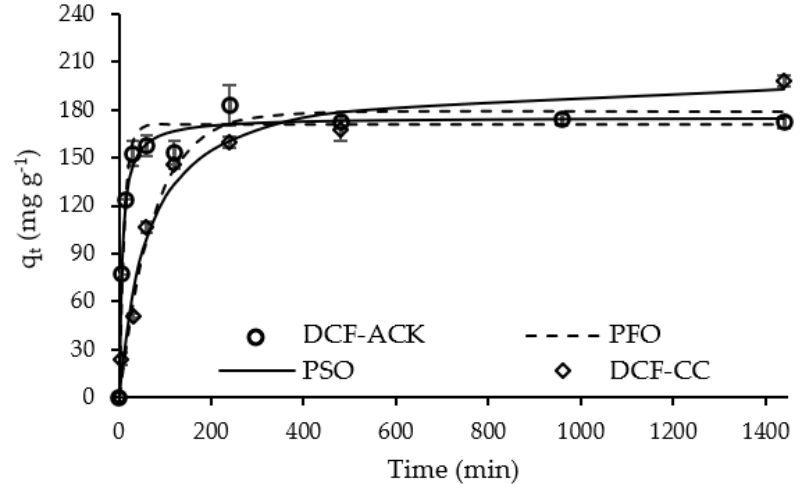
Figure 5. Kinetic curves of DCF adsorption for ACK and CC carbons (Adsorbent mass = 10 mg; DCF initial concentration = 100 mg L − 1 ; Solution volume = 25 mL; Solution initial pH = 6.00). Dots—experimental data; Lines—kinetic model adjustments.